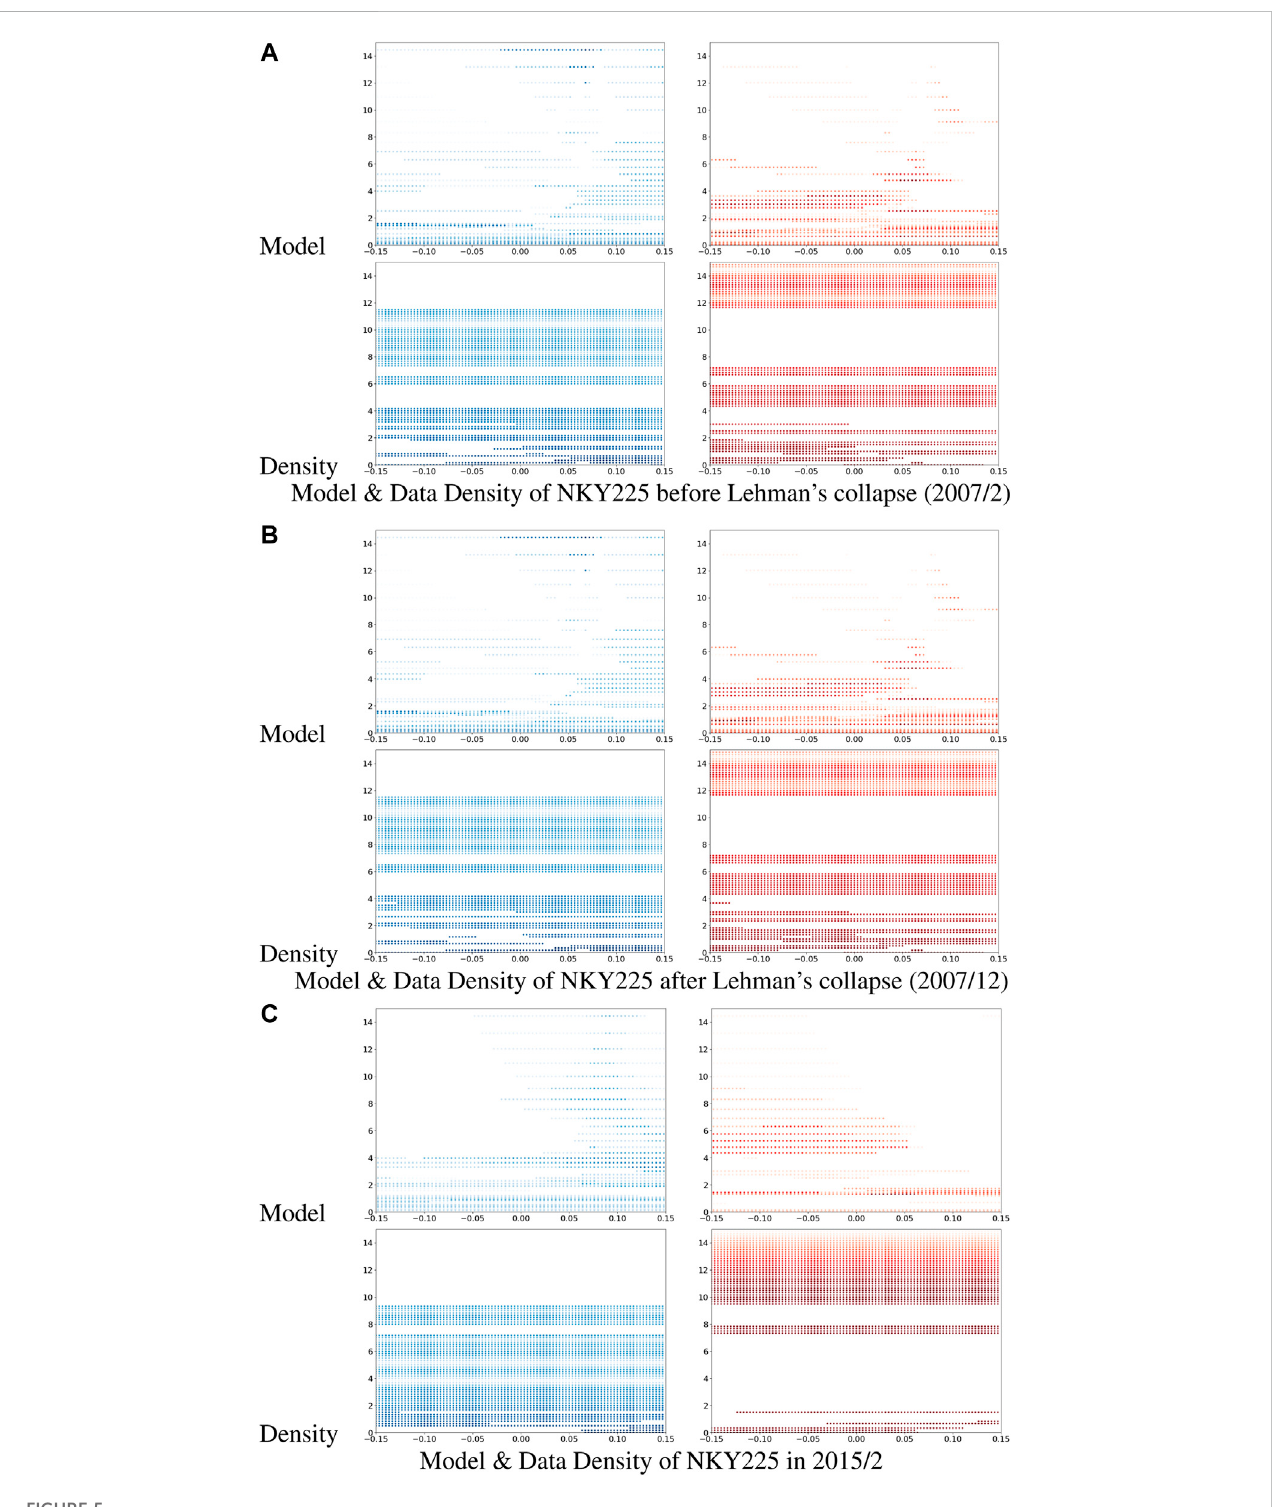
FIGURE 5 Model & Data Density of NKY225. (A) Model & Data Density of NKY225 before lehman ’ s collapse (2007/2). (B) (A) Model & Data Density of NKY225 after lehman ’ s collapse (2007/12). (C) Model & Data Density of NKY225